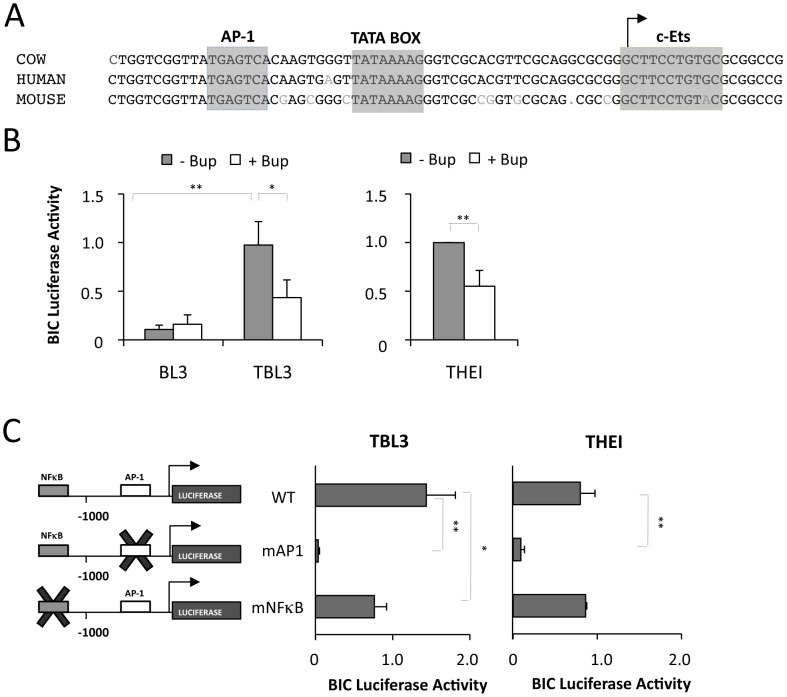
The transcriptional induction of miR-155 in Theileria infected-cells is dependent on AP-1.
(A) Sequence alignment of the proximal promoter sequence of the bovine, human and mouse BIC genes. The highly conserved AP-1 sites and TATA box are highlighted. The TSS is indicated by an arrow. (B) Luciferase reporter analysis of BIC promoter activity in cells infected with Theileria (TBL3 or THEI) or non-infected BL3 cells, with or without Buparvaquone treatment. All experiments were normalized by co-transfection with Renilla constructs (average ± sd, n = 3). (C) The effect of mutating AP-1 (mAP1) or NFκB (mNFκB) binding sites in BIC promoter luciferase assays was tested in TBL3 or THEI cells (average ± sd, n = 3). *p<0.05, **p<0.01.